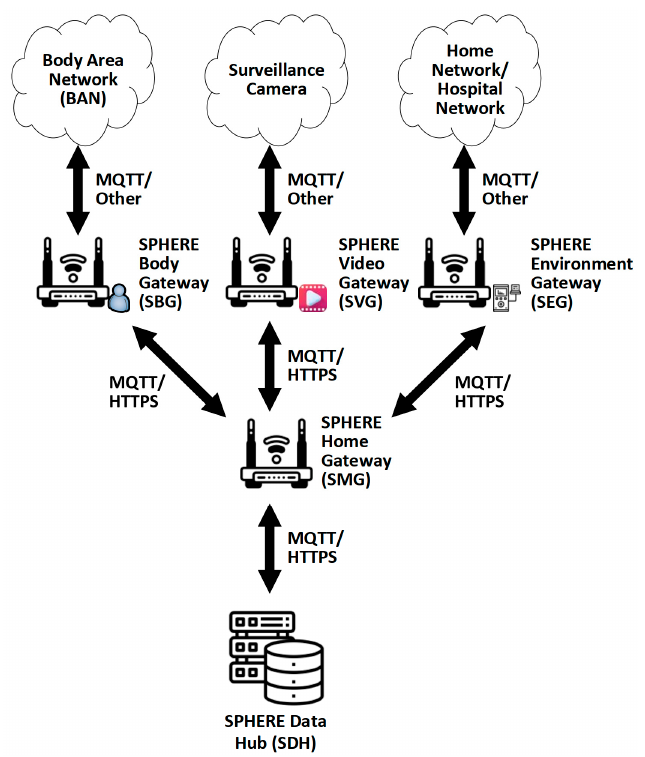
Figure 4. AAL system architecture (modified from